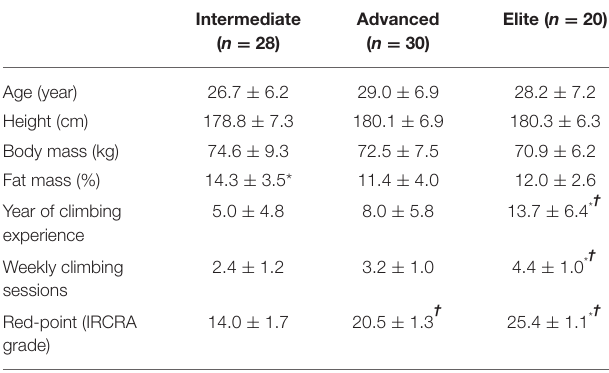
TABLE 1 | Anthropometric data, climbing experience, weekly climbing sessions and self-reported climbing ability (IRCRA